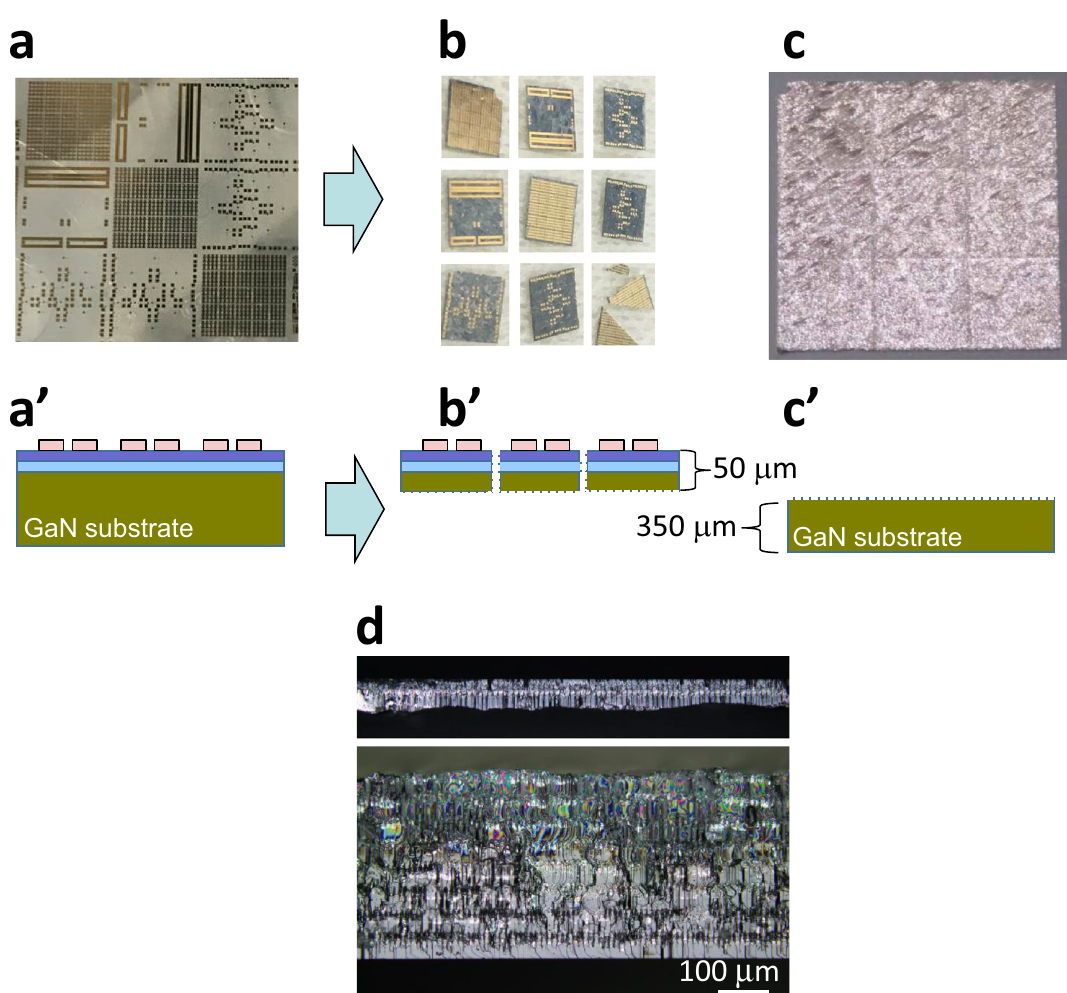
Figure 2. Photographs of sample before and after laser process. ( a ) As-fabricated on-wafer HEMTs. ( b ) 5-mm-square HEMT chip of 50 µm thickness. ( c ) 15-cm-square substrate of 350 µm thickness. a’, b’, c’ Schematics of cross-sectional structures of a, b, and c. ( d ) Cross-sectional photographs of sliced samples. Device-side sample (one of those in b, upper) and substrate-side sample (c,